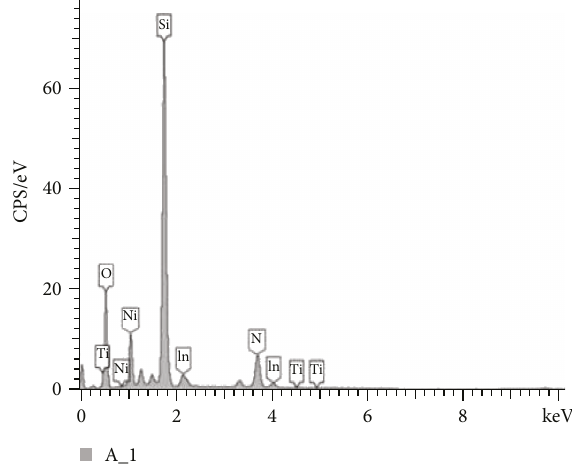
Figure 6: EDX of fabricated ITO/TiO solar cell.